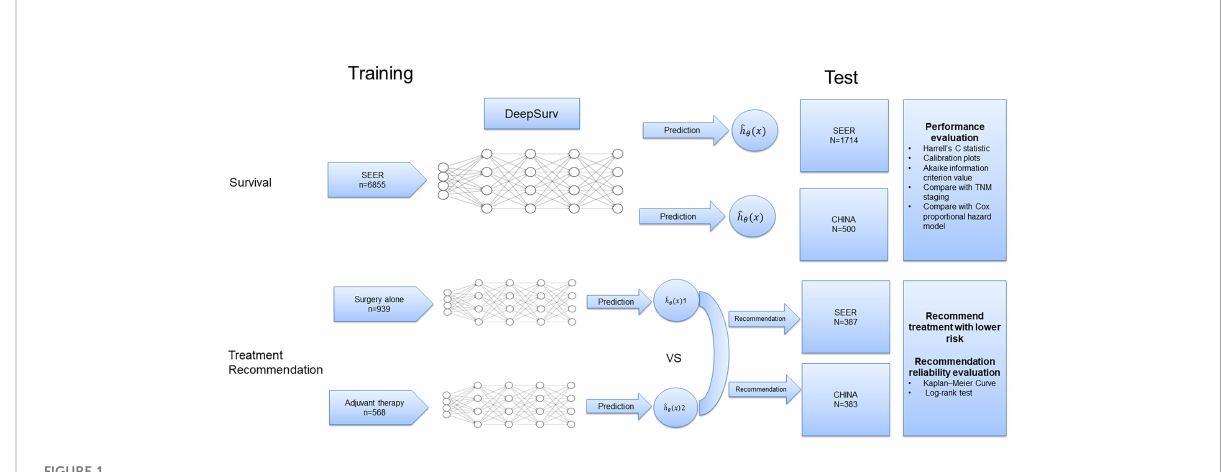
FIGURE 1 Diagram of the study